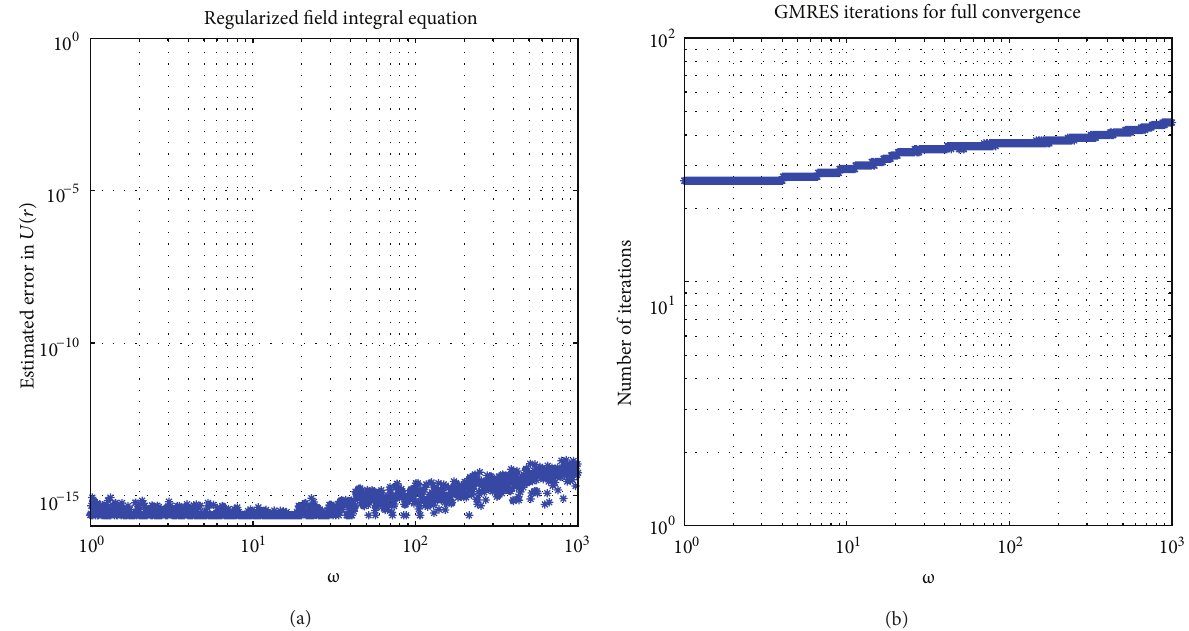
Figure 16: The same exterior Neumann problem for Helmholtz equation as in Figure 15, but RCIP is now applied to (68). The program demo13b.m is